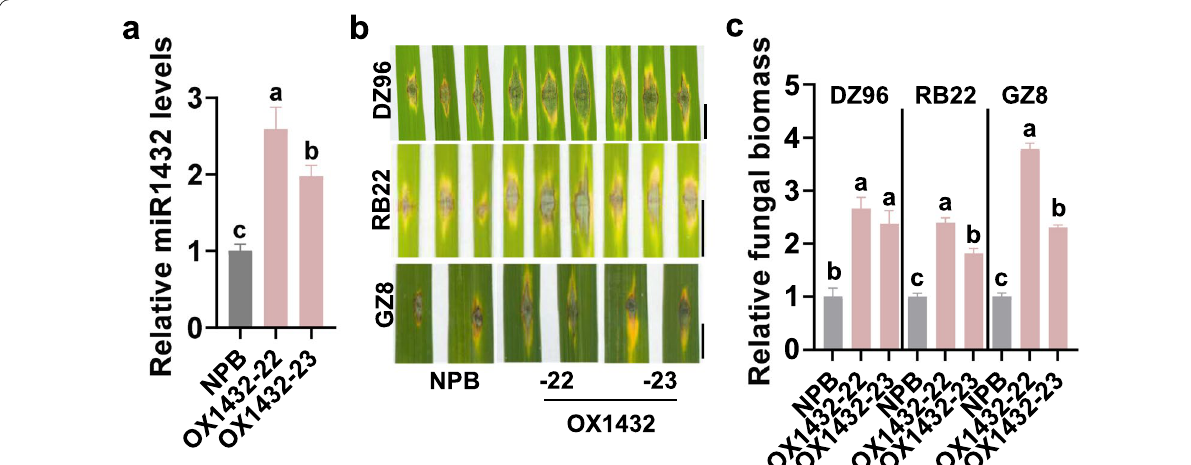
Fig. 1 Overexpression of miR1432 enhances rice susceptibility to Magnaporthe oryzae . a The relative amount of mature miR1432 in the transgenic lines overexpressing MIR1432 gene (OX1432) and the Nipponbare (NPB) control. Reverse‑transcription (RT) was carried out with total RNA and a miR1432 specific stem‑loop RT primer (Additional file 2: Table S2). The RT product was subsequently used as a template for quantitative polymerase chain reaction (q‑PCR) to detect the amounts of miR1432. The amounts of snRNA U6 were examined and used as an internal reference. b The blast disease phenotypes on leaves 5 days post‑inoculation of M. oryzae strains GZ8, RB22, and DZ96, respectively. Bar 5 mm. c The relative fungal = biomass of the indicated strains in OX1432 and the Nipponbare control. The fungal biomass was determined by using the ratio of DNA levels of M. oryzae MoPot2 against the DNA levels of rice ubiquitin . Error bars indicate SD (n 3 independent samples). Different letters above the bars indicate = significant differences ( P < 0.01) as determined by One‑way Tukey–Kramer analysis. Similar results were obtained in at least two independent